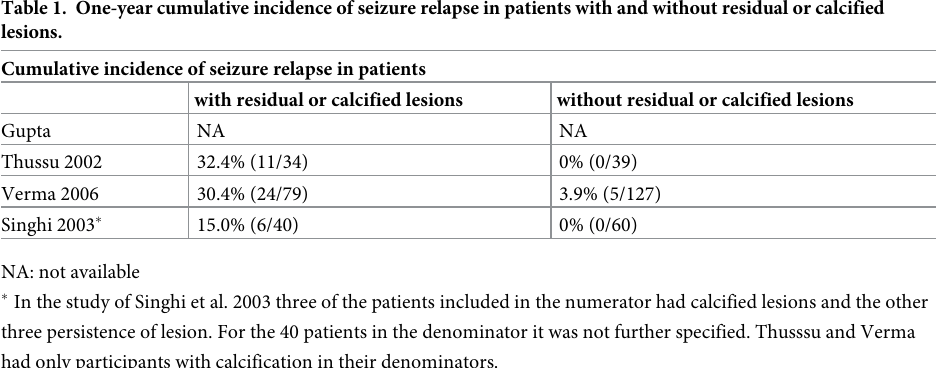
Table 1. One-year cumulative incidence of seizure relapse in patients with and without residual or calcified lesions. Cumulative incidence of seizure relapse in patients with residual or calcified lesions without residual or calcified lesions